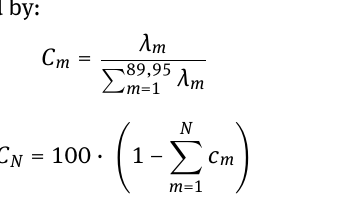
The sufficient number of modes for the